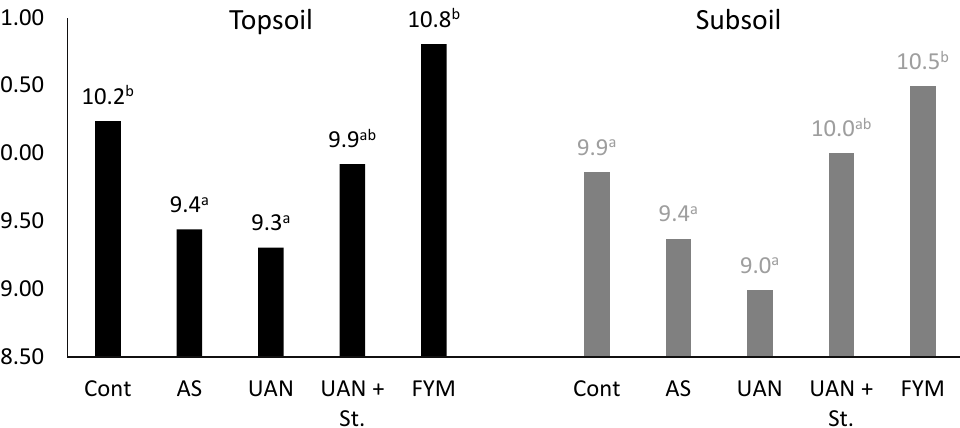
Figure 6. Soil organic matter carbon (C SOM ) / soil total nitrogen (N t ) ratio in topsoil and subsoil; different letters behind the values mean significant differences among investigated treatments (Tukey test; p < 0.05); number of replications per treatment n = 4.